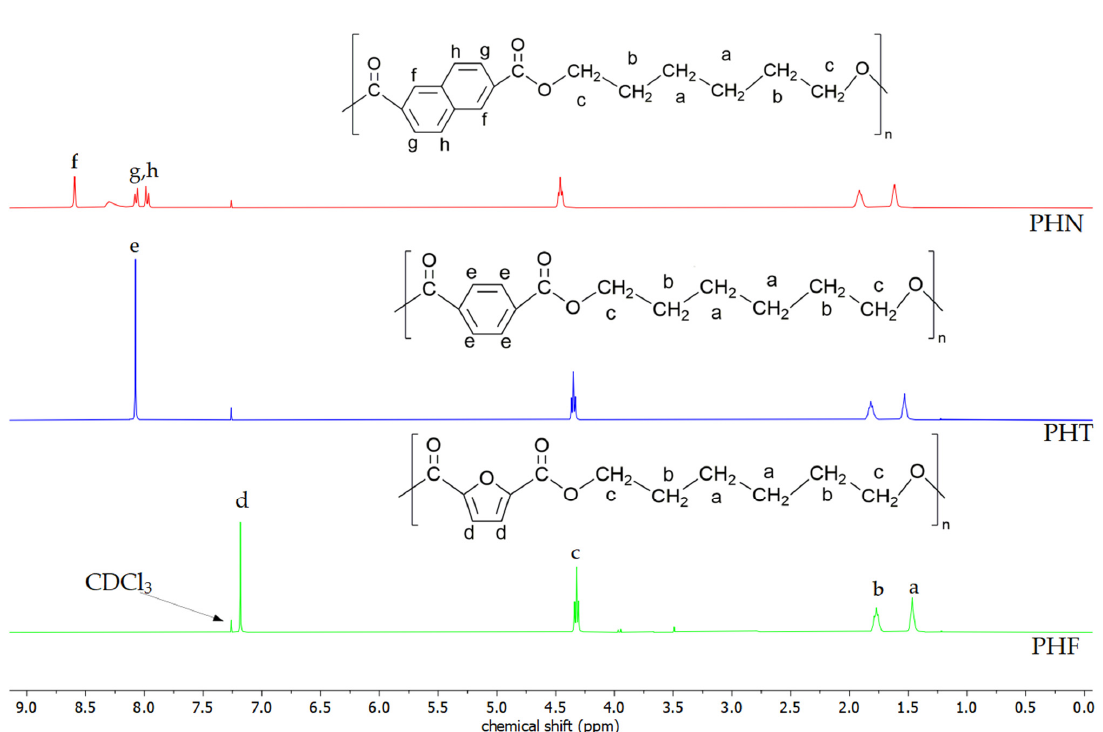
Figure 3. Structure and NMR spectra of PHF and PHF-b-F-pTHF 50/50.